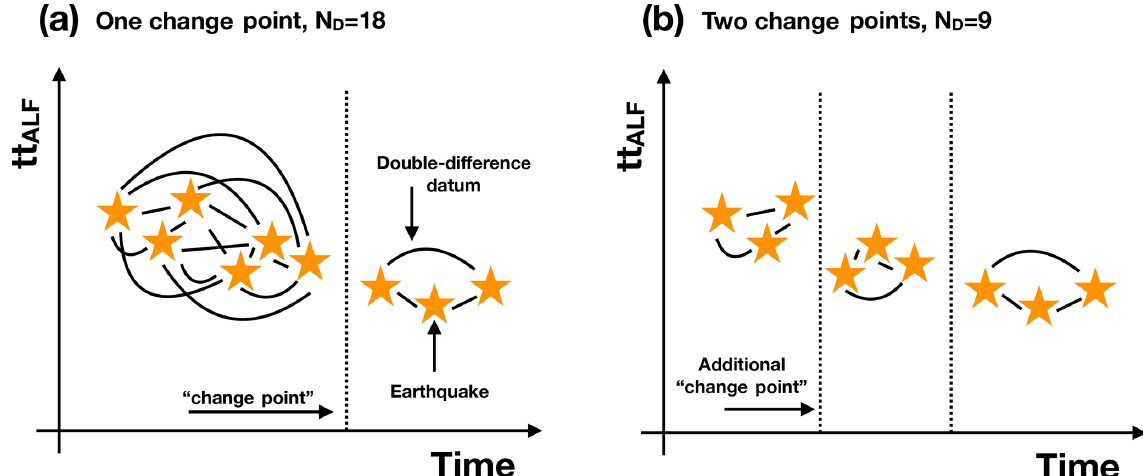
Figure 1. Schematic example of the standard preparation of DD data in different time windows. Time windows are defined by changepoints (also called “hard partitions”). Here, for the sake of simplicity, we represent the travel time to station ALF for each seismic event (yellow stars) as a function of origin time. A DD datum (curved black line) is prepared for each pair of events not separated by a changepoint. (a) Here, only one changepoint is present, so N D = 18 DD data can be prepared. (b) In the case of two changepoints, only N D = 9 DD data can be